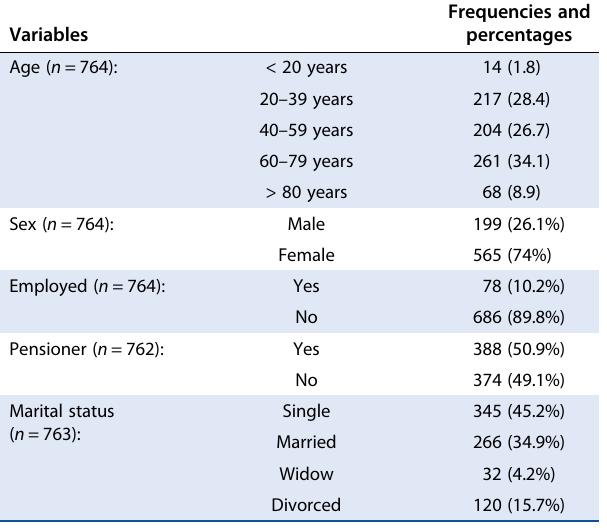
Table 1: Baseline characteristics